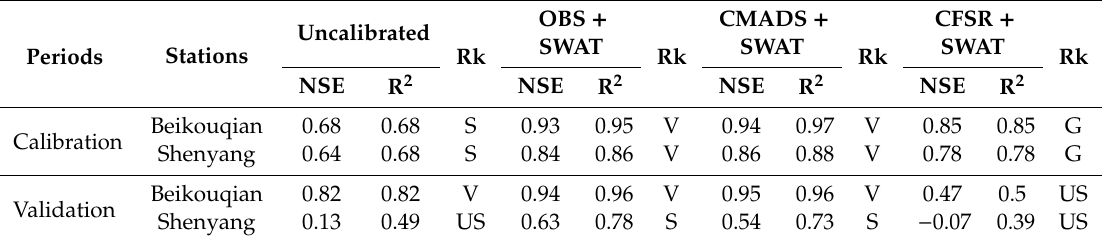
Table 6. The evaluation indicators for monthly runo ff